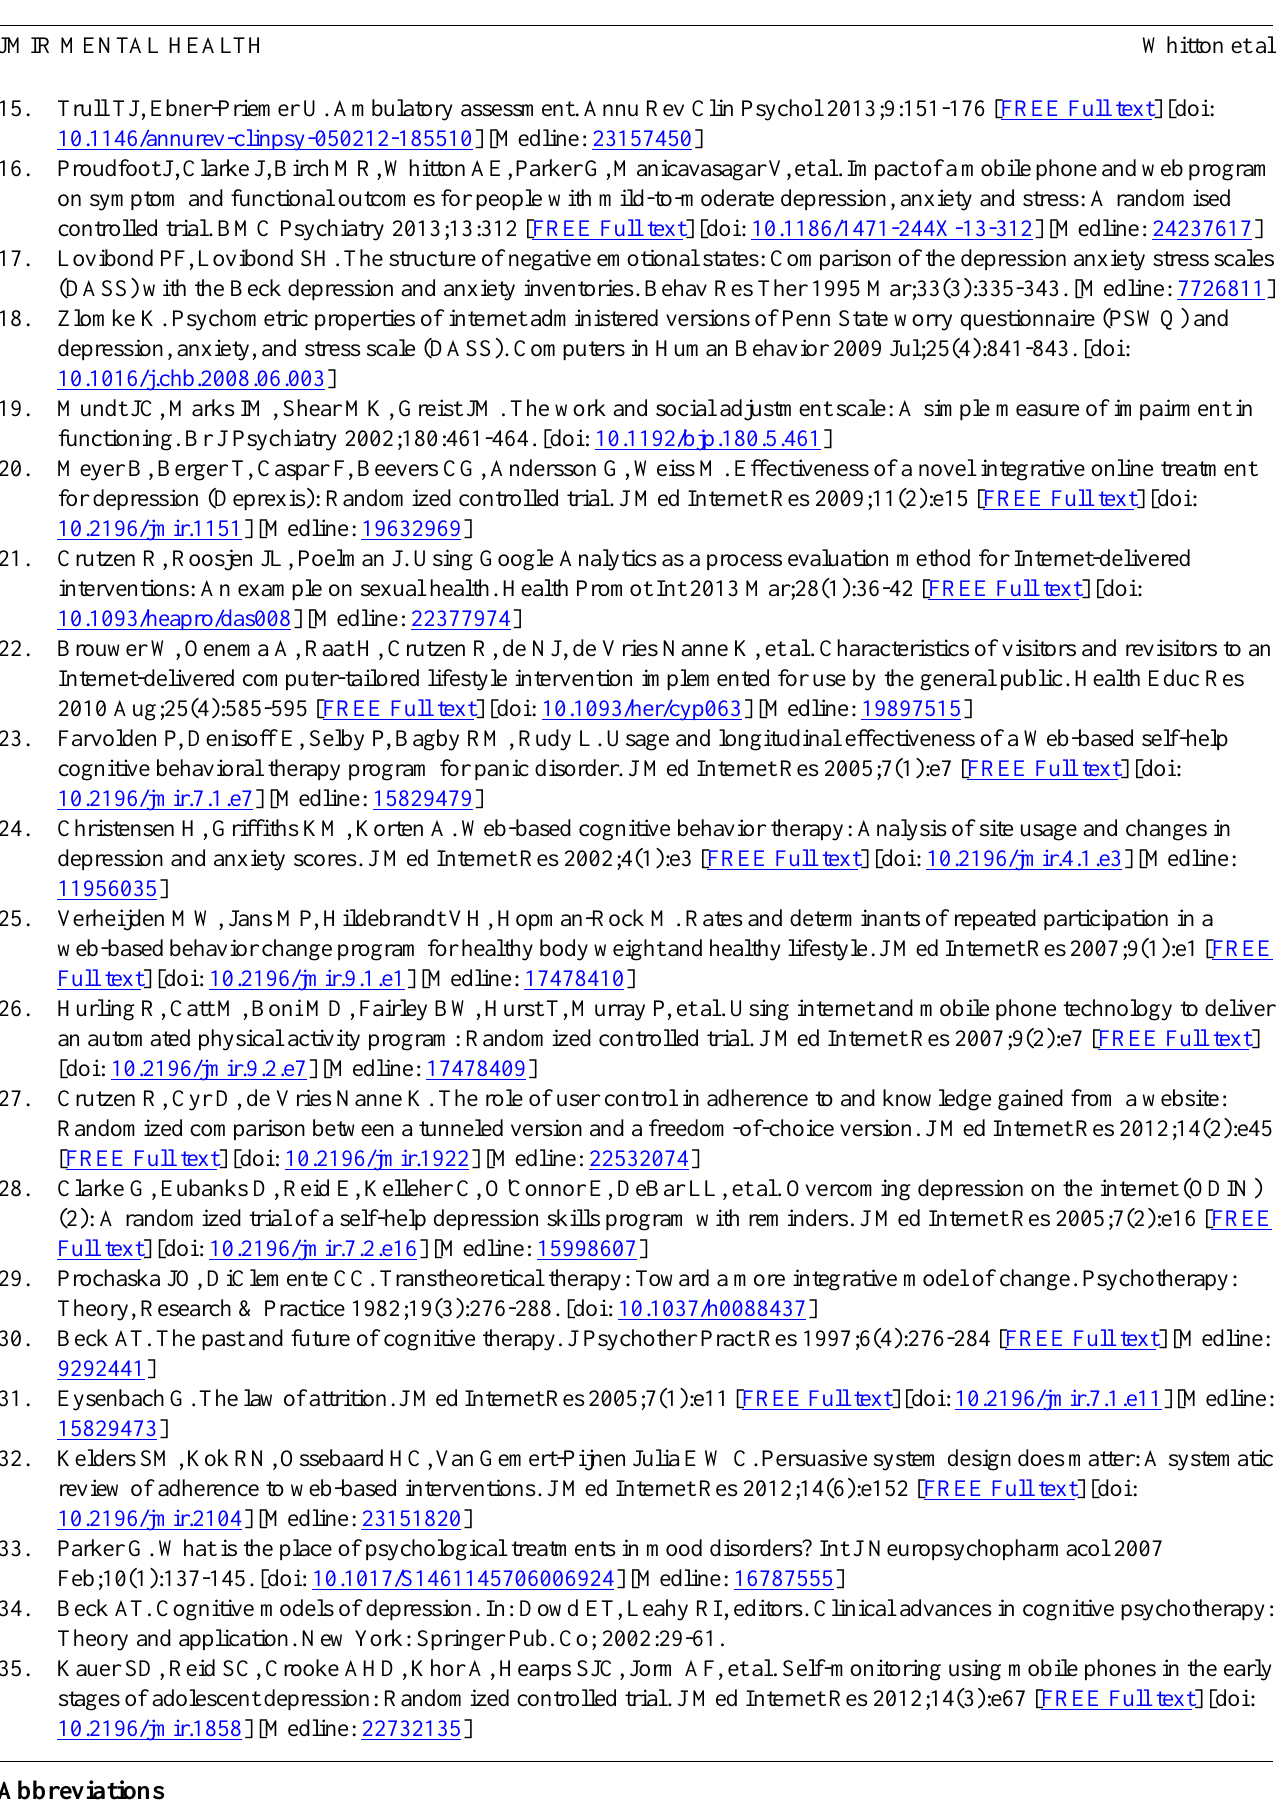
DASS: Depression, Anxiety, and Stress